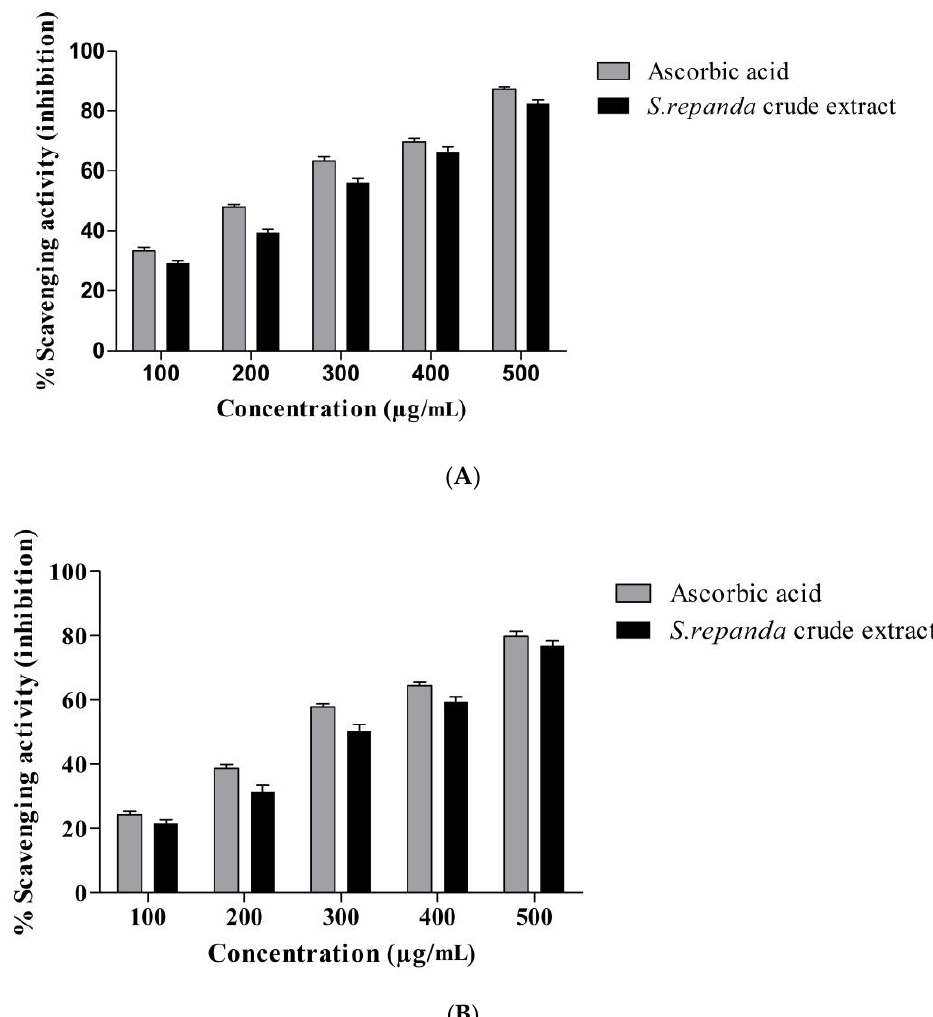
Figure 1. Antioxidant activity of ascorbic acid (standard) and S. repanda crude extract against ( A ). DPPH molecules. ( B ). H 2 O 2 molecules. Error bars indicate SDs (±standard deviation) of three inde- ( B ). H 2 O 2 molecules. Error bars indicate SDs ( ± standard deviation) of three independent experiments ( p < pendent experiments ( p < 0.05).